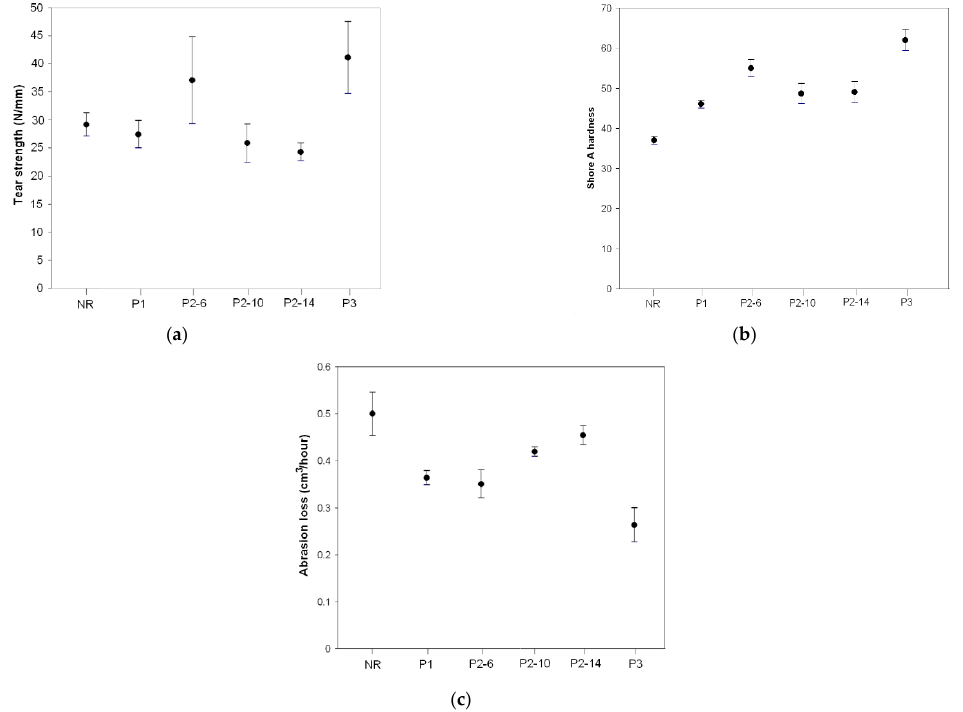
Figure 7. Other properties of the different rubber matrix composites: ( a ) tear strength (N/mm) (average and standard deviation), ( b ) Shore A hardness (average and standard deviation), and ( c ) abrasion loss (cm 3 /hour) (average and standard deviation). Table 3. Summary of the mechanical results (avg. values) of all rubber matrix composites.